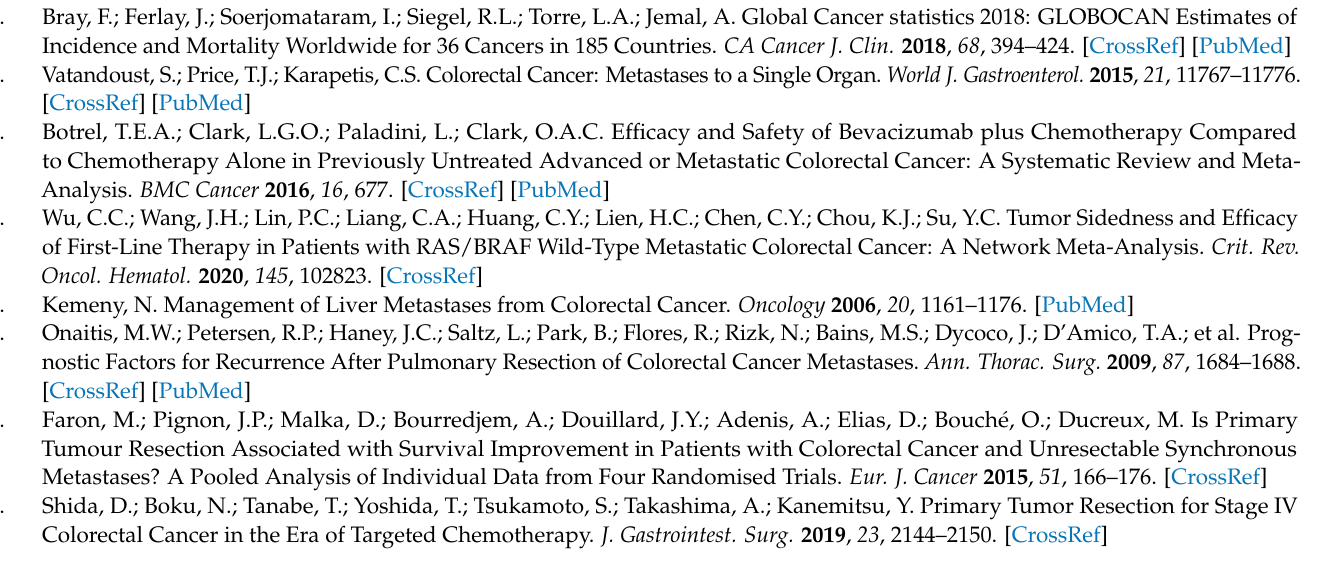
Table S3: HRs of overall survival among patients without primary tumor resection after PS matching (1:1) and PS weighting by targeted therapy; Table S4: HRs of overall survival in the overall population after PS matching (1:1) and PS weighting by targeted therapy; Table S5: Subgroup analysis of treatment effectiveness by tumor